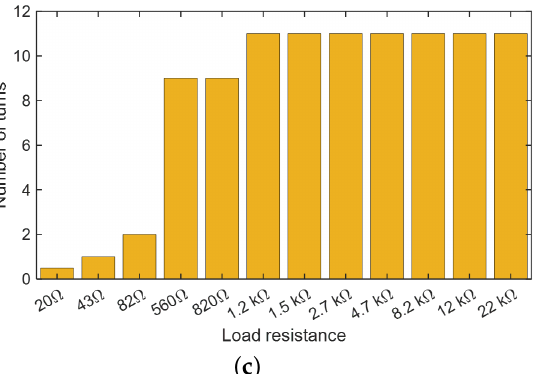
Figure 5. Generated pulses from the DC generator for different load resistances: ( a ) 82 Ω , ( b ) 4.7 K Ω . Rectangular signal presents the pendulum turns. ( c ) Pendulum number of turns required to release as function of several load resistances.